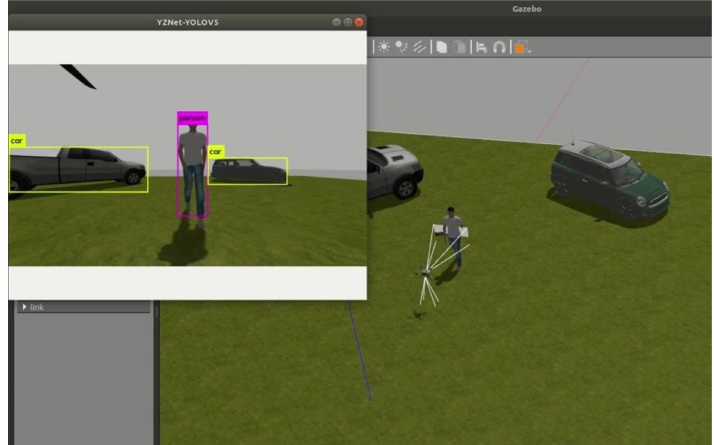
Figure 11. The target-tracking test is carried out in the Gazebo